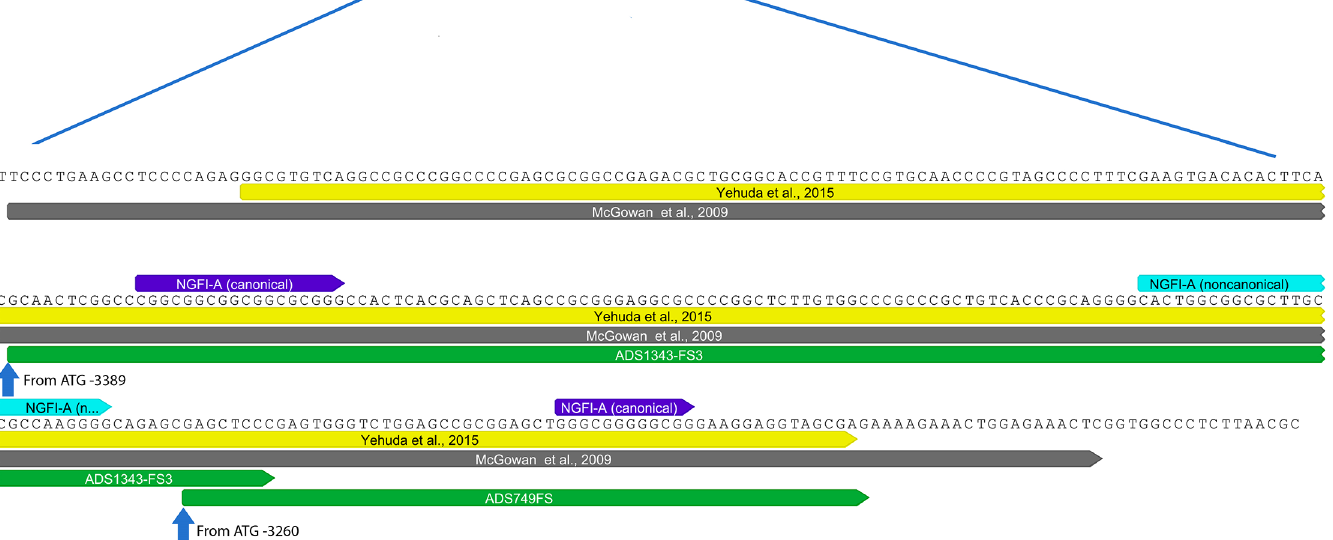
Fig 1. Map of the NR3C1 -1F region. This was quantified for methylation in comparison to previous studies (8, 26), indicating canonical and noncanonical binding regions.